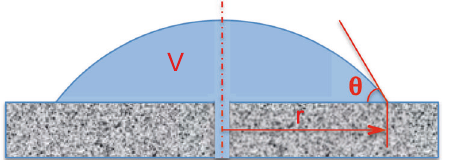
Fig. 1 Sketch of sessile drop, injected from below through a sub- millimetric hole in the substrate. V is drop volume, r is wetted radius, θ is macroscopic contact